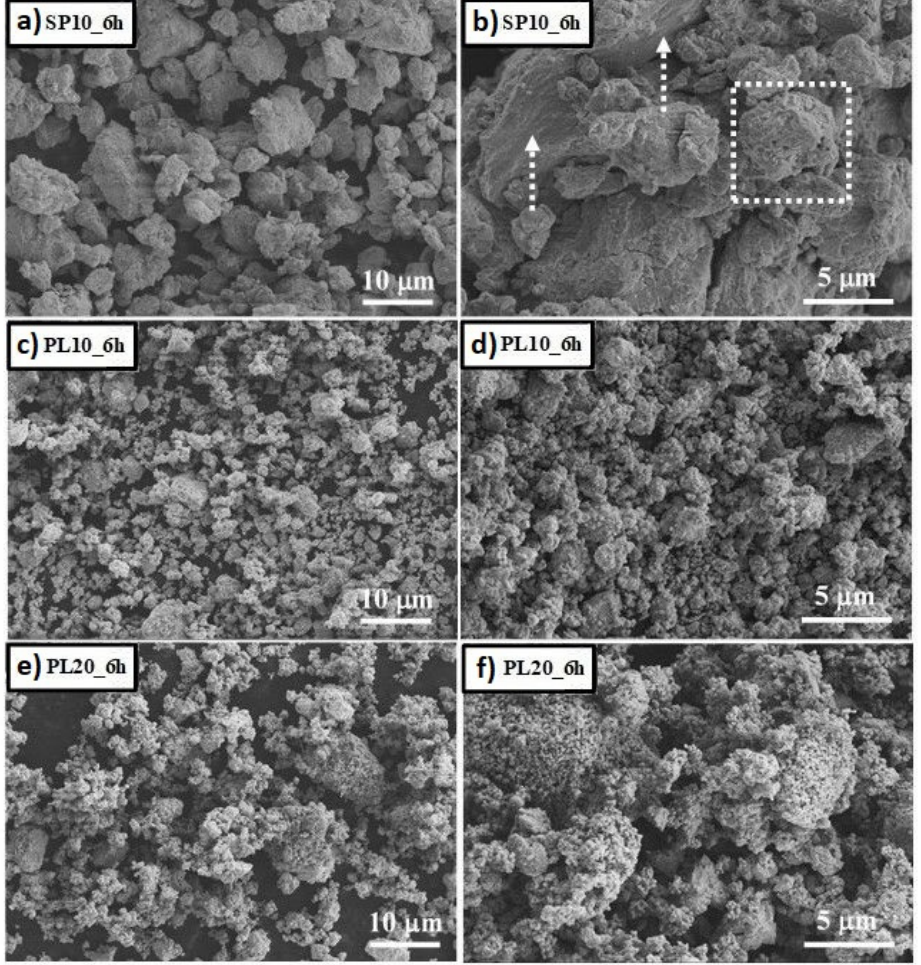
Figure 5. Scanning electron microscopy (SEM) images for the TiNb15Mn alloy milled at 6 h and for both 8000D mixer/mill ® and PM400 devices and at BPR equal to 10 and 20, i.e., SP10_6h ( a , b ), PL10_6h ( c , d ) and PL20_6h ( e , f ). Cold-welded particles are marked with dotted squares, and the typical fractured particles are marked by dotted arrows.